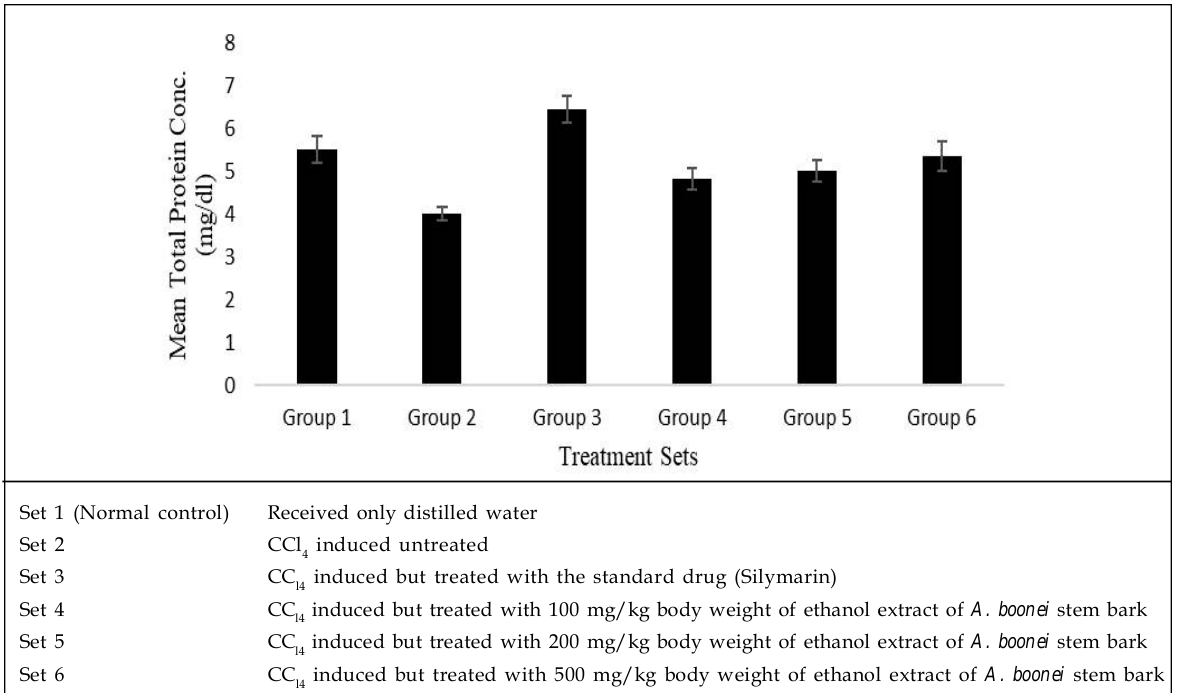
) induced male Wistar albino rats 4